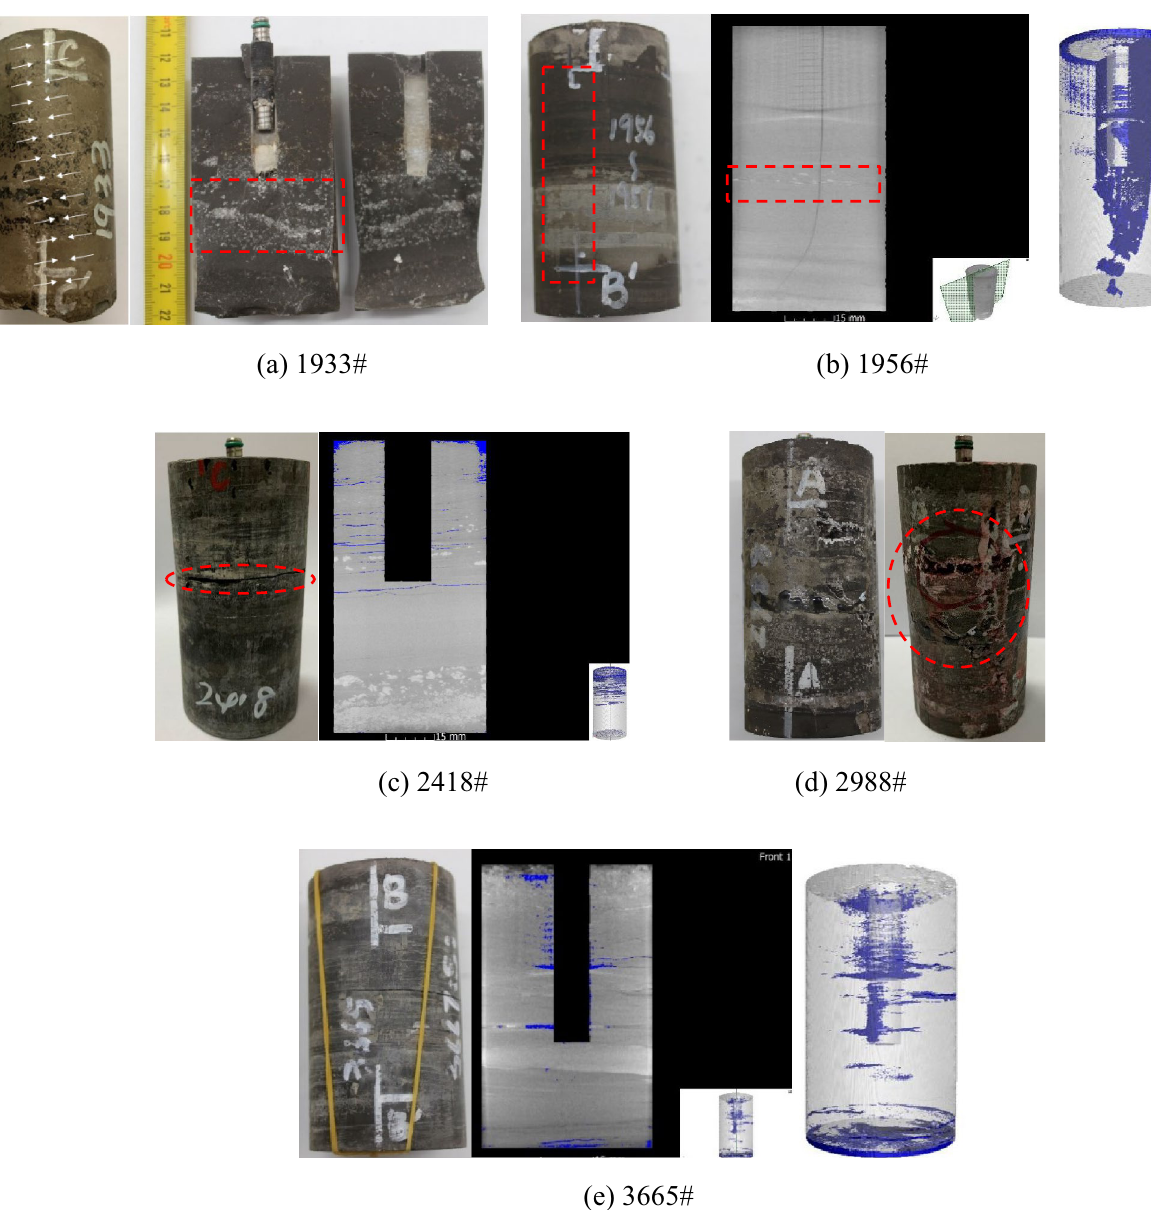
Fig. 15 Fracture morphology characteristics of shale samples after